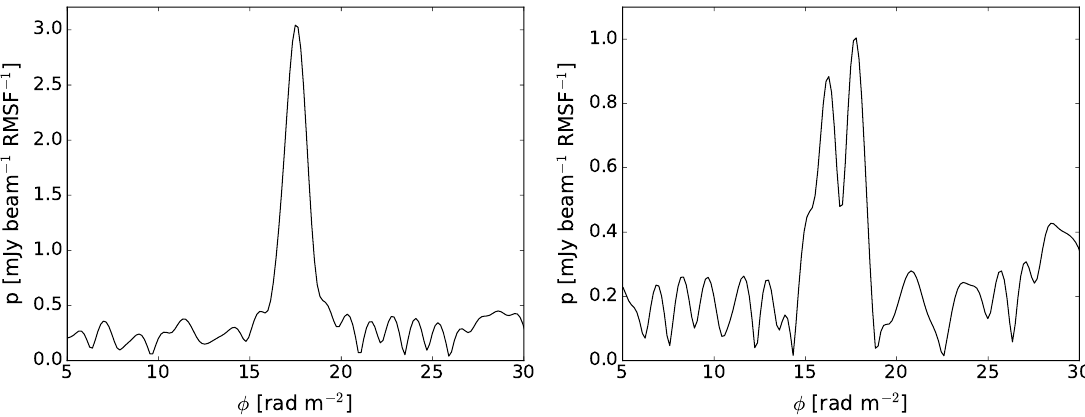
Figure 6. Example FDFs from blazar ILT J141945.53+542314.4 (shown in Figure 4, bottom right). ( Left panel ) Simple FDF of the blazar core with a polarised intensity of ∼ 3 mJy beam − 1 at a Faraday depth of 17.5 radm − 2 ; ( right panel ) complex FDF of the western extension of the blazar, with a peak of ∼ 1.0 mJy beam − 1 at 17.7 radm − 2 , and a second peak of ∼ 0.88 mJy beam − 1 at 16.2 radm − 2